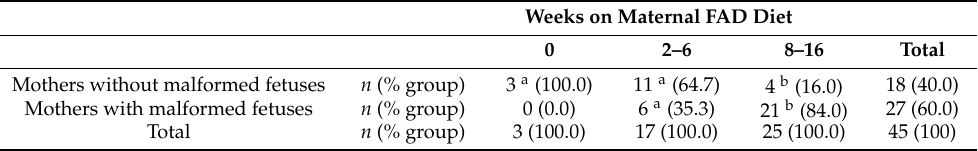
Table 3. Number of mothers with malformed fetuses per week on a maternal FAD